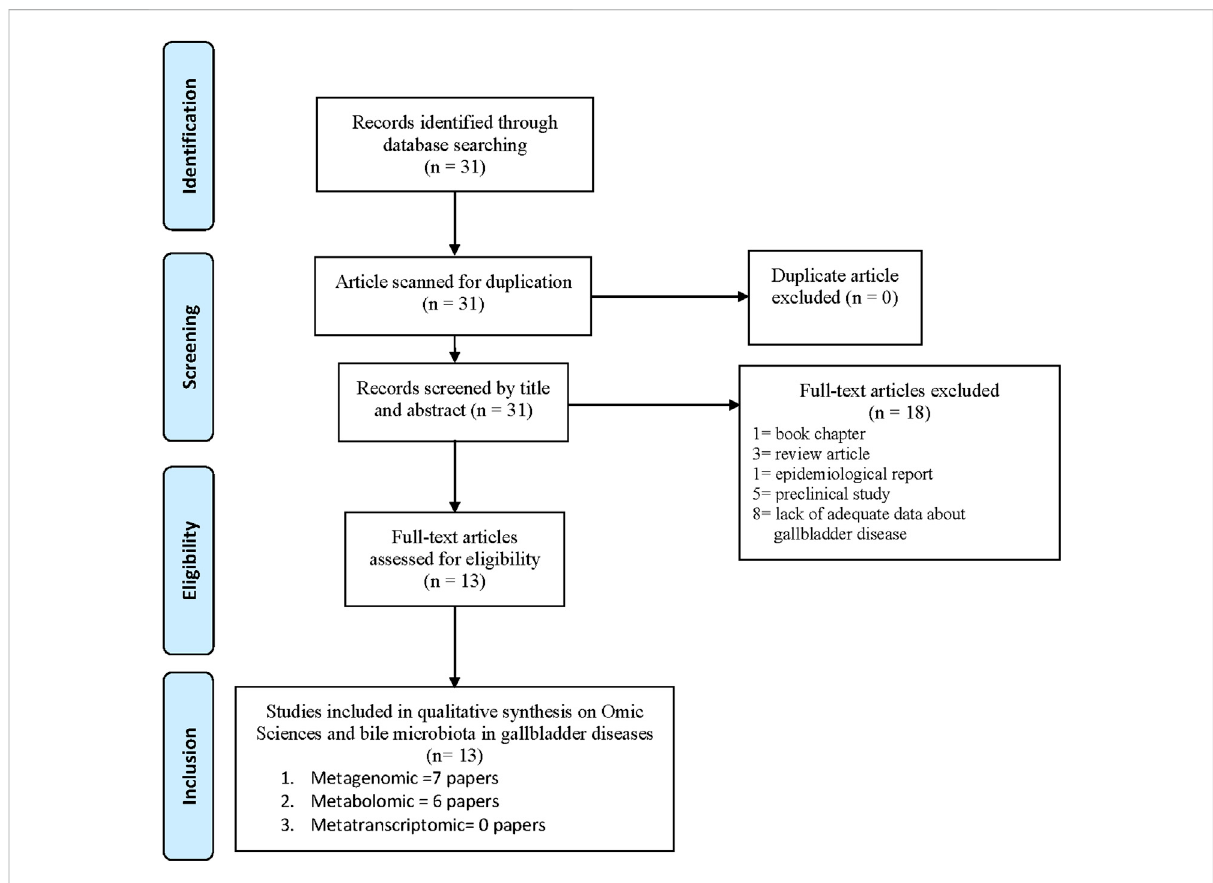
FIGURE 1 PRISMA Flow Chart showing the selected